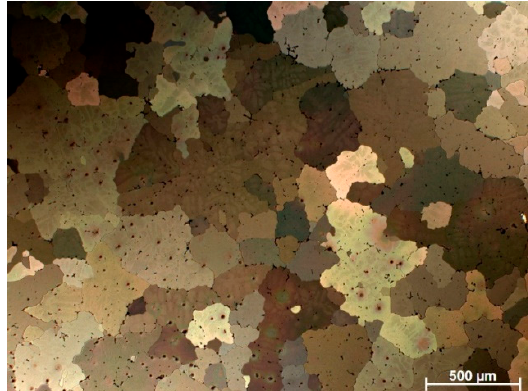
Figure 1. Polarised light microstructure of the AlMg5 alloy in a solution treated state observed under polarised light.